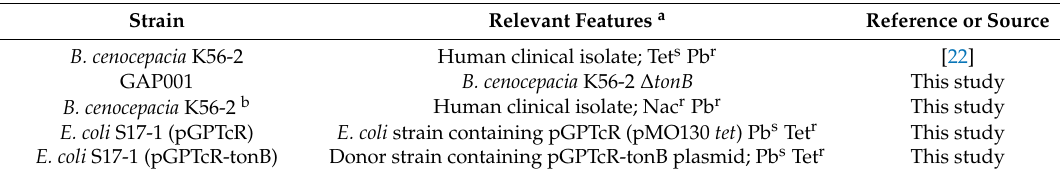
Table 1. Bacterial strains used in this